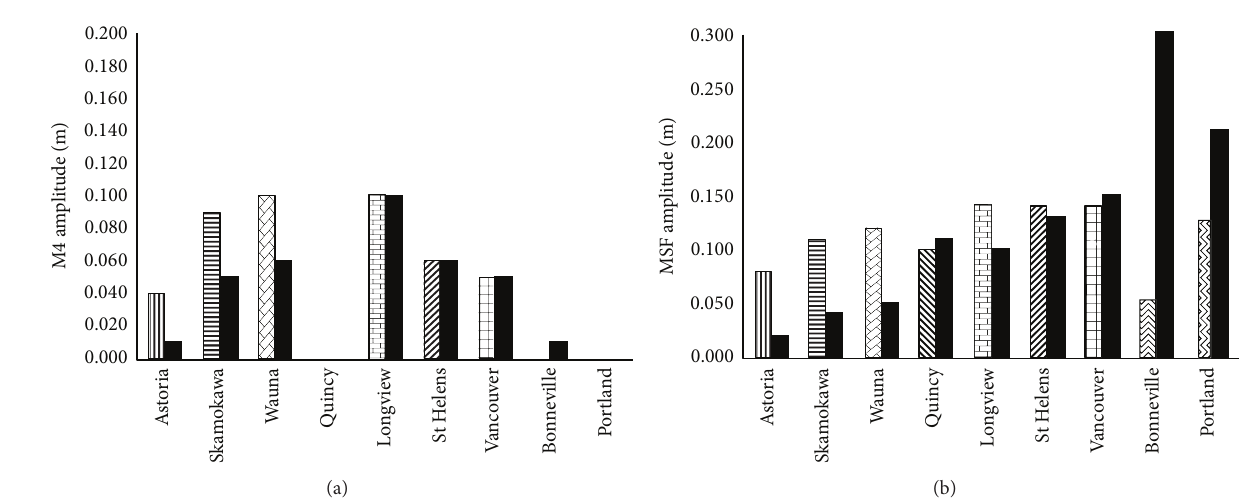
Figure 10: Amplitudes (a) M4 and (b) MSf (hatch is model, solid is